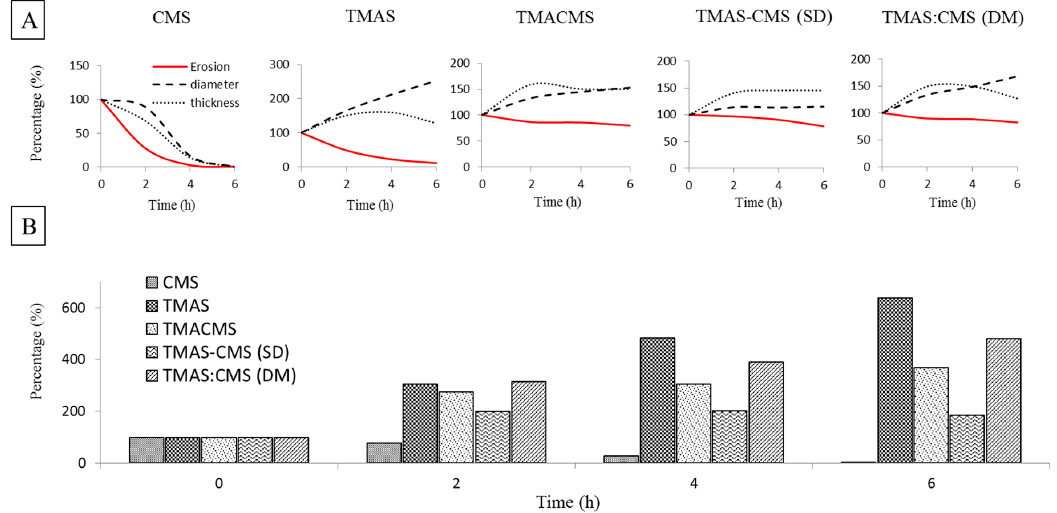
Figure 6. ( A ) Erosion, diameter, and thickness changes of placebo tablets of CMS, TMAS, TMACMS, TMAS-CMS (SD), and TMAS:CMS (DM) at 0 h (dried), 2 h in SGF, 4 h (2h SGF + 2h SIF) and 6 h (2 h SGF + 4 h SIF). ( B ) Fluid uptake of placebo tablets of CMS, TMAS, TMACMS, TMAS-CMS (SD),